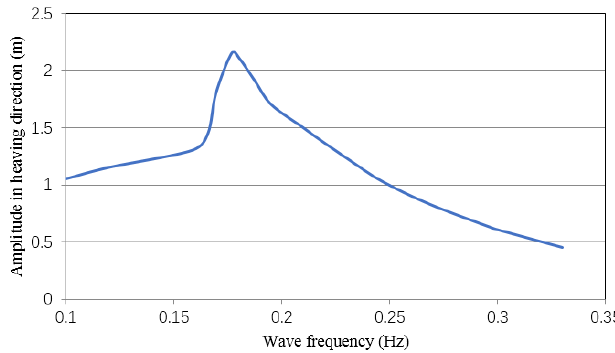
Energies 2018 , 11 , x FOR PEER REVIEW Figure 11. Amplitude of the float motion in the heaving direction. Figure 11. Amplitude of the float motion in the heaving direction.